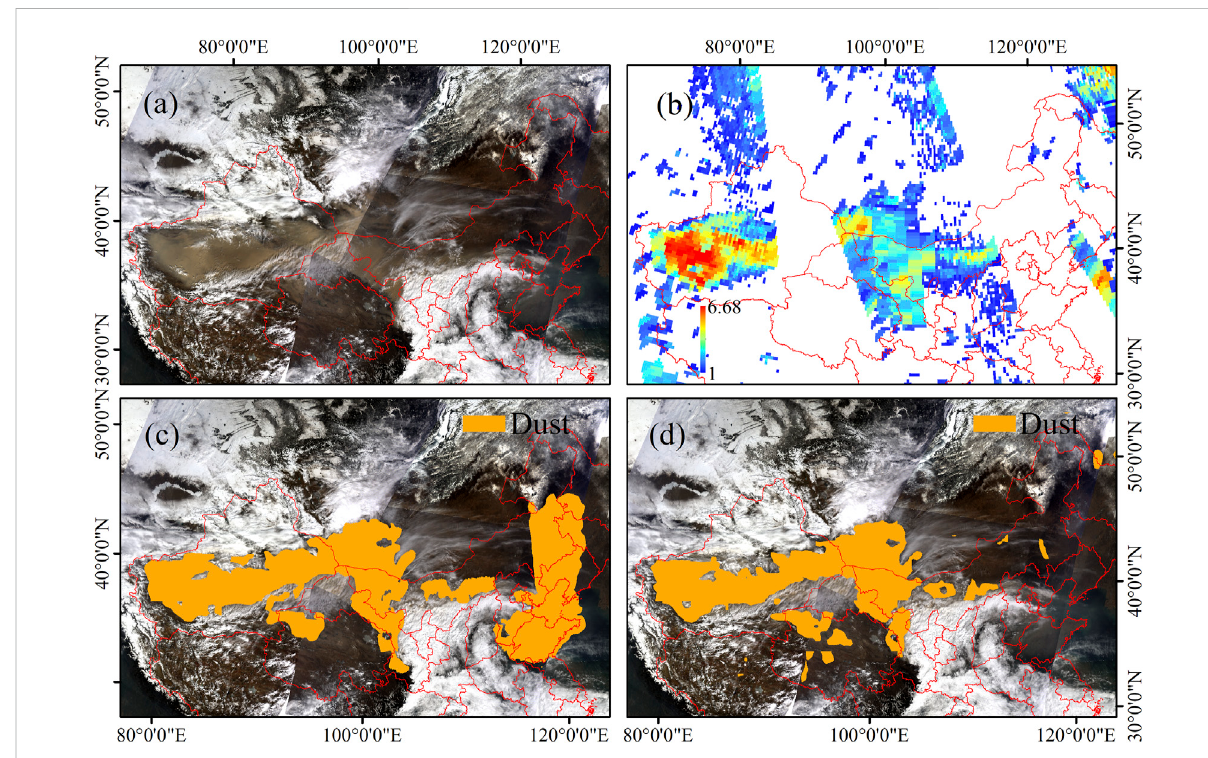
FIGURE 7 SpatialdistributionsofMODISRGBimage(band:1-4-3) (A) ,OMIAIproduct (B) ,detectionresultsofspacesandstormsinMODISimageswithLSR (C) , and detection results of space sandstorms in MODIS images without LSR (D) on 17 March